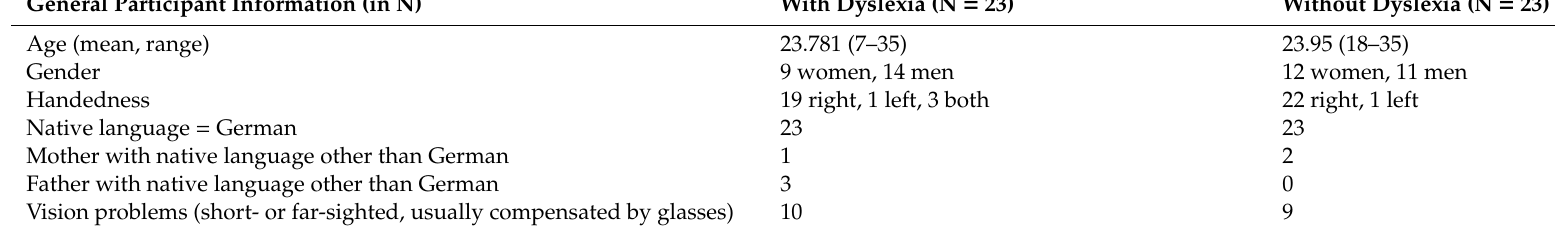
Table 1. Summary of the results of all questions from the questionnaire as well as all musical and cognitive tests for both the group of adults with versus without dyslexia. General Participant Information (in